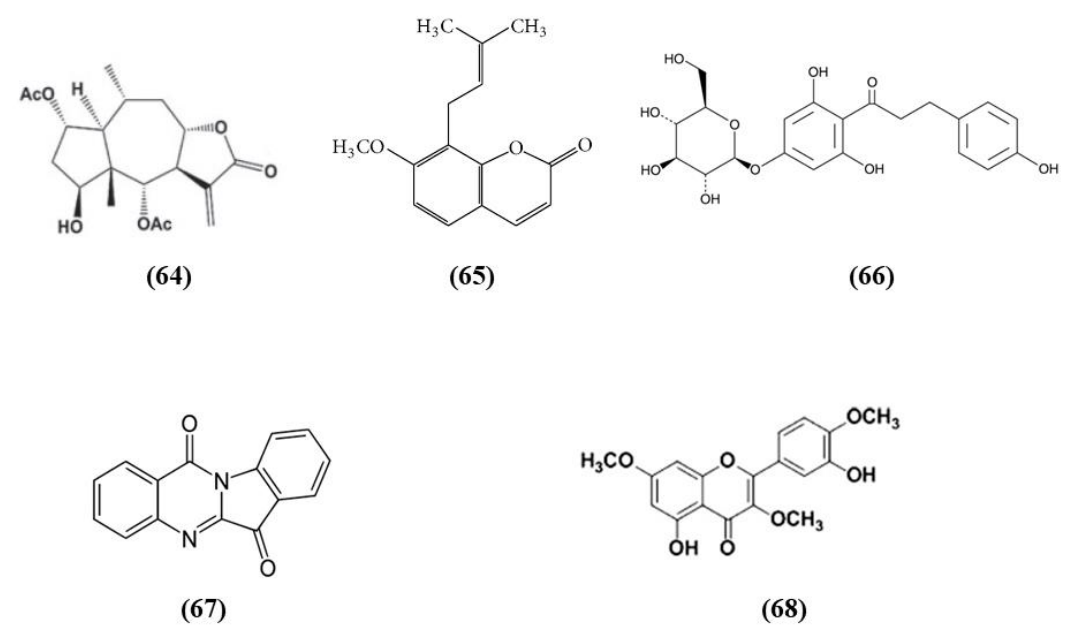
Figure 12. Chemical structure of ( 64 ) britanin, ( 65 ) osthole, ( 66 ) trilobatin, ( 67 ) tryptanthrin, and ( 68 ) 5,3′ -dihydroxy- 3,7,4′